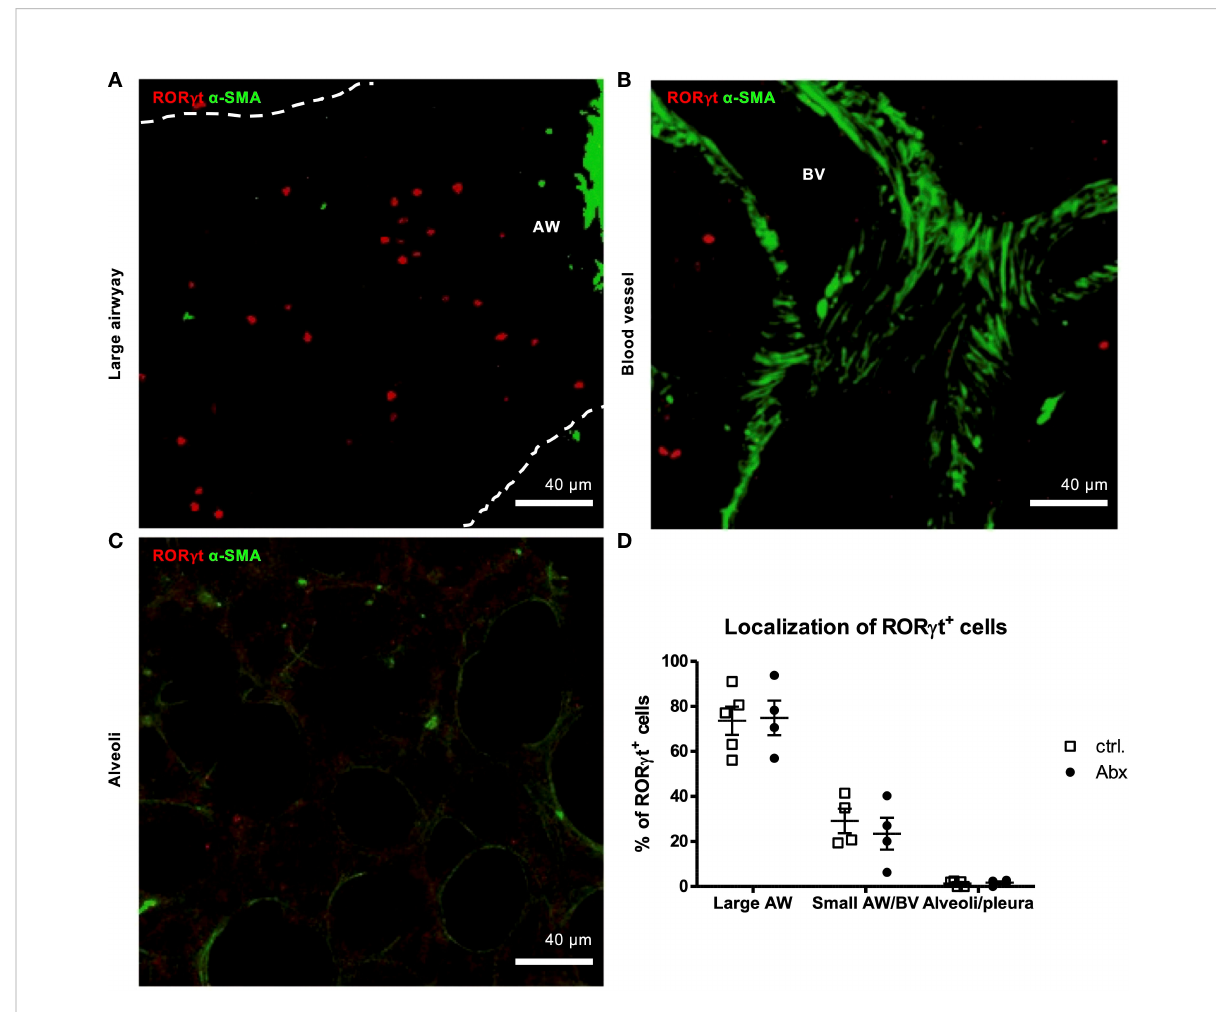
FIGURE 4 Prenatal antibiotic exposure of dams does not in fl uence localization of offspring pulmonary ROR g t + cells in situ . C57BL/6 mice were treated with vancomycin, ampicillin and gentamycin (all at 1.0 mg/mL)(Abx) from prenatal day 15 until birth. Mice treated with sucralose served as controls (ctrl.). At 6-8 weeks, offspring C57BL/6 mice were immunized i.p. with 10 µg/100 µL of HDM. Seven days later mice received an additional i.p. injection of HDM. After 14 and 21 days mice were treated with 100 µg/40 µL HDM i.t. 72 h after the last treatment 300 µm lung sections of agarose fi lled lungs were prepared. (A, B) For visualization of airways and blood vessels anti-aSMA (green) was added. (C) Alveoli were identi fi ed by auto fl uorescence. (D) Stained slices were evaluated with laser scanning confocal microscopy generating Z-Stacks for localization of ROR g t + cells (red). Abbreviations: AW, airway; BV, blood vessel. Data are representative of at least four independent experiments. Scatter plot with mean ± SEM. n = 4-5 mice. Each dot represents the Z-stack of one